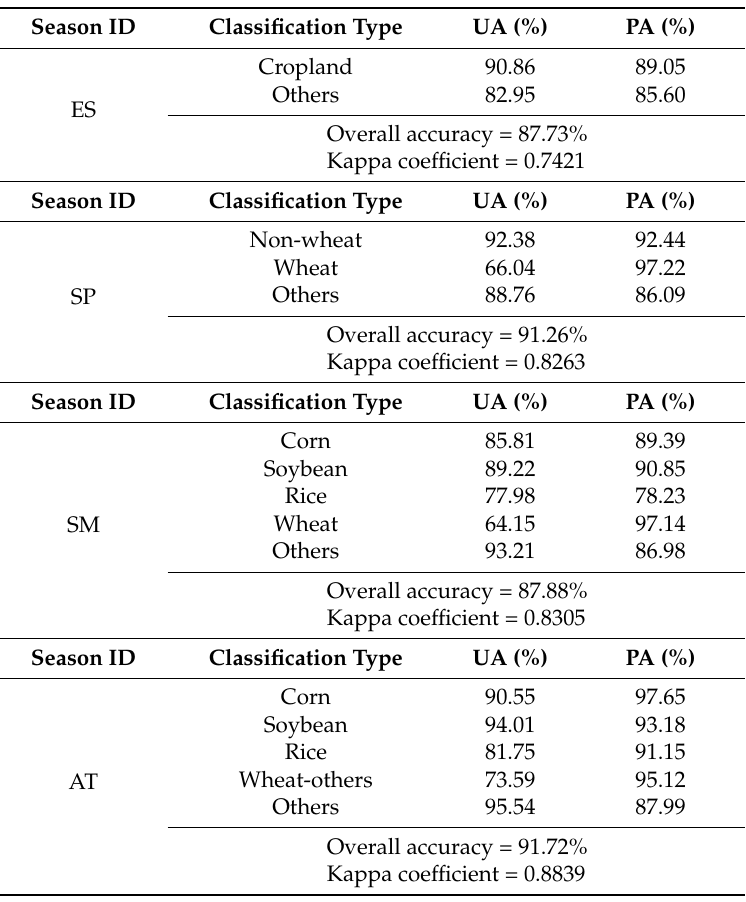
Table 4. Classification accuracy for in-season crop